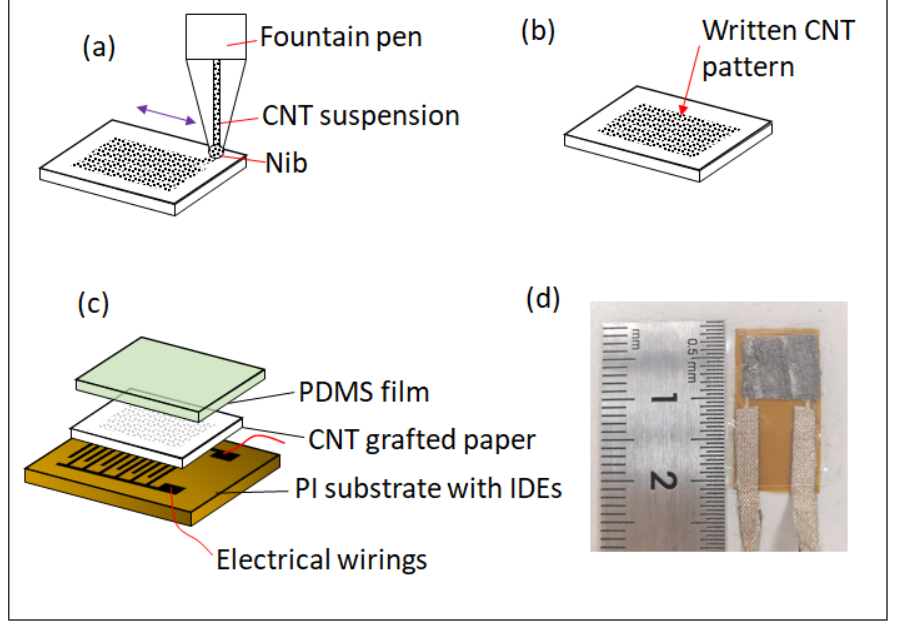
Figure 1. ( a ) Direct writing CNT suspensions onto tissue paper. ( b ) Paper with written CNT pat- terns. ( c ) Assembling a piezoresistive element. ( d ) Photo of a fabricated piezoresistive element.